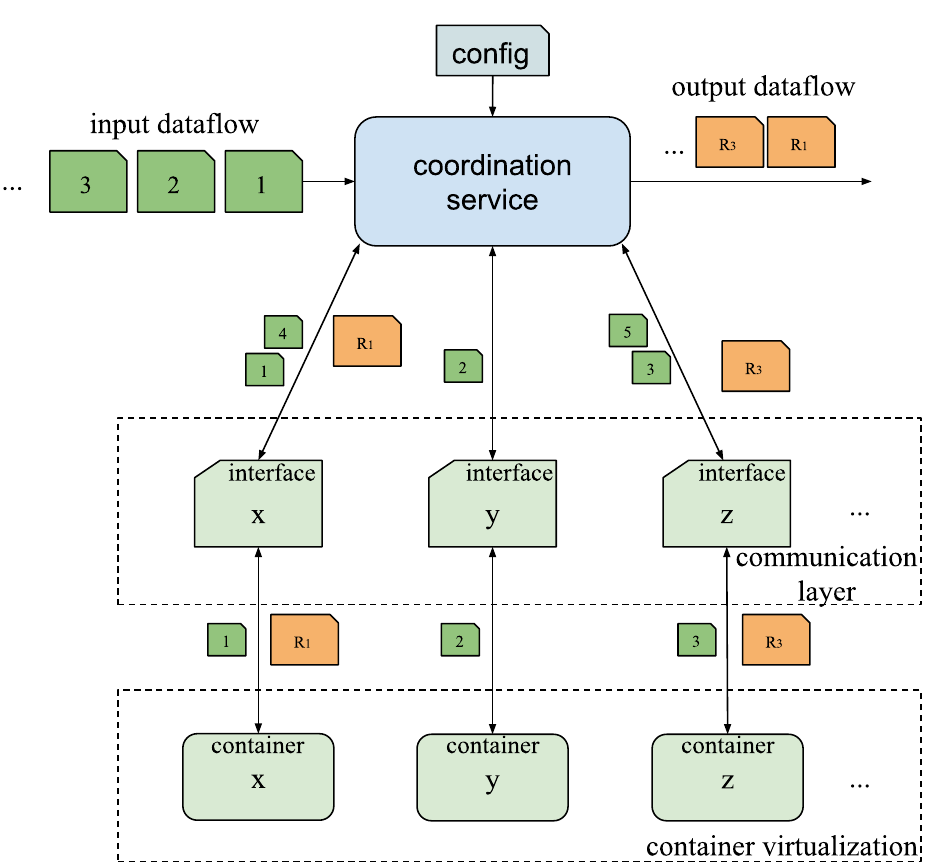
Figure 4. Example of the parallelization and coordination concept with unsorted result